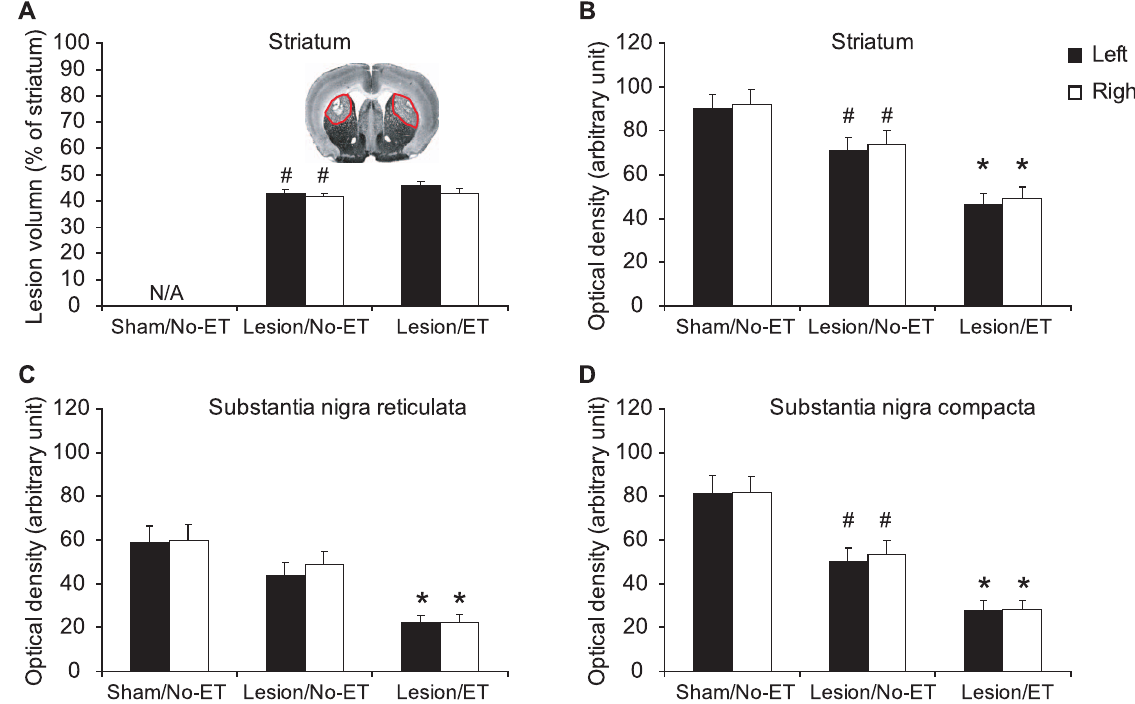
Figure 3. 6-OHDA lesions. Shown are the effect of bilateral striatal lesions on (A) lesion volume (% of striatal volume), (B) tyrosine hydroxylase (TH) staining of the striatum, (C) TH staining of the substantia nigra reticulata (SNR), and (D) TH staining of the substantia nigra compacta (SNC). # : significant difference between sham rats without exercise training (Sham/No-ET) and lesioned rats without ET (Lesion/No-ET), P , 0.05, Student’s t test. *: significant difference between Lesion/No-ET and Lesion/ET, P , 0.01, Student’s t test. The inset in (A) shows a representative TH stained coronal section showing bilateral depletion of TH (outlined in red).